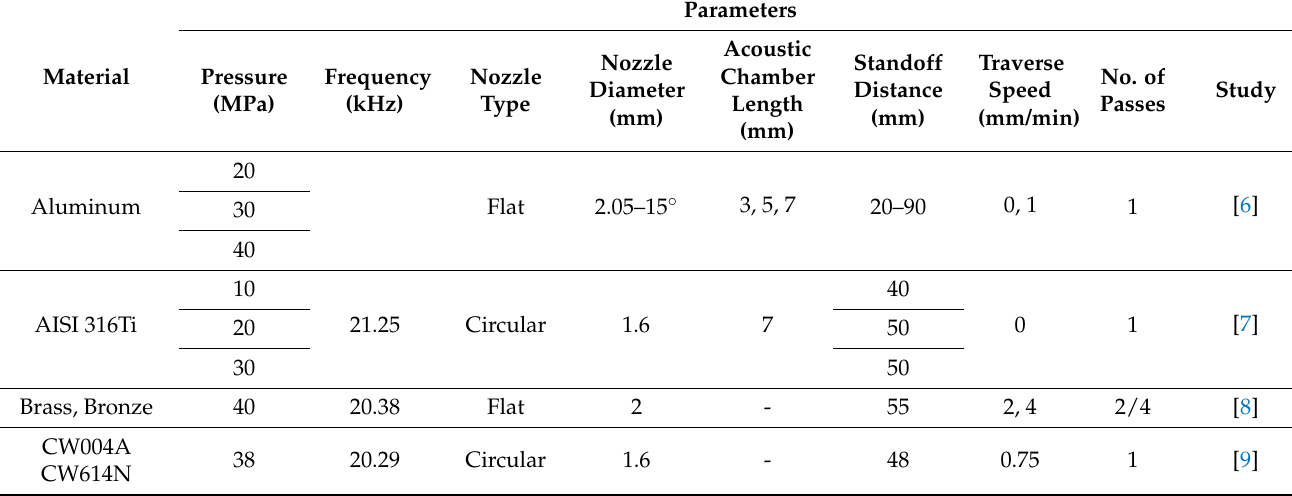
Table 1. Results of recent studies dealing with the evaluation of pulsating water jet (PWJ) interactions.